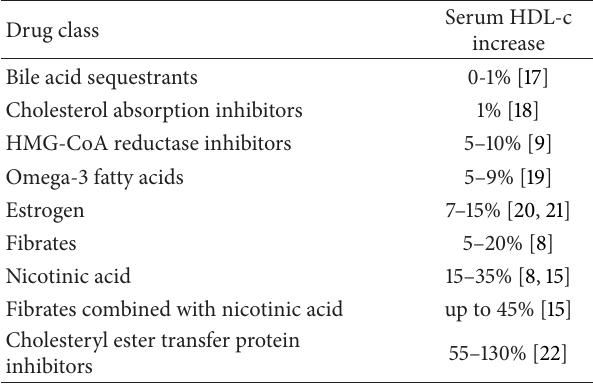
Table 2: Reported HDL-c changes with lipid targeting